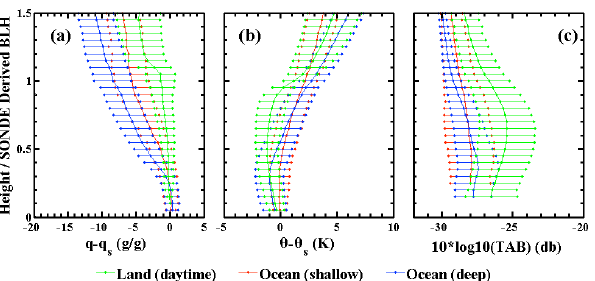
Figure 3. Diurnal cycle of boundary layer aerosol structure at the marine site (2007-2008, top panel) and the continental site (2007-2009, bottom panel). The black cross in each figure represents the BLH derived from SONDE with the RI number method.